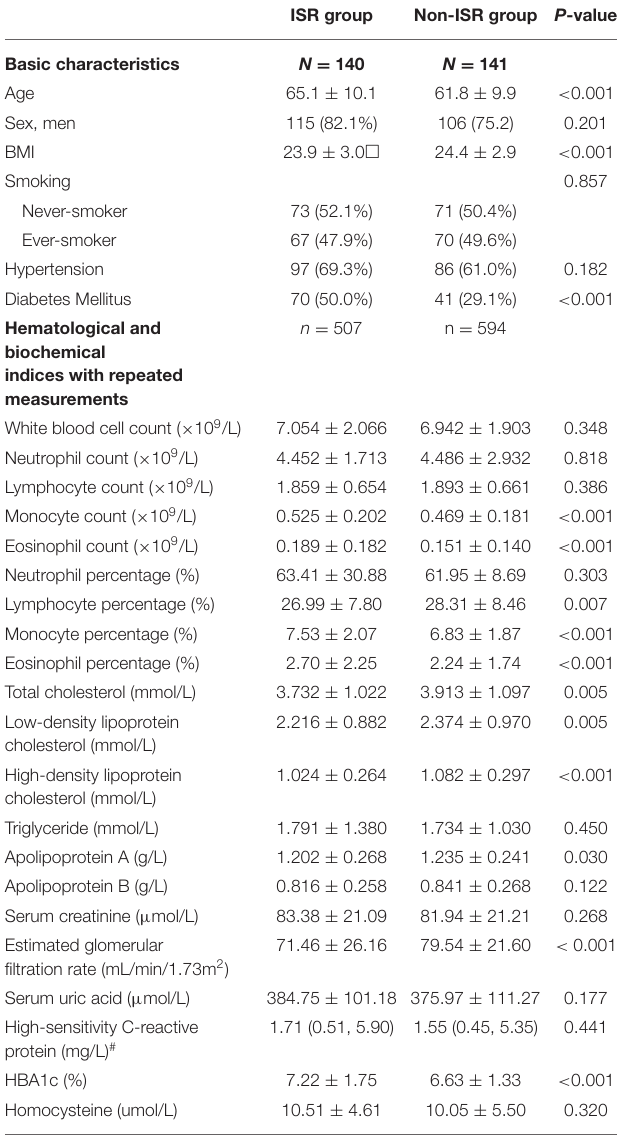
TABLE 1 | Data description of basic characteristics and main hematological and biochemical indices between postoperative in-stent restenosis (ISR) and non-ISR group *